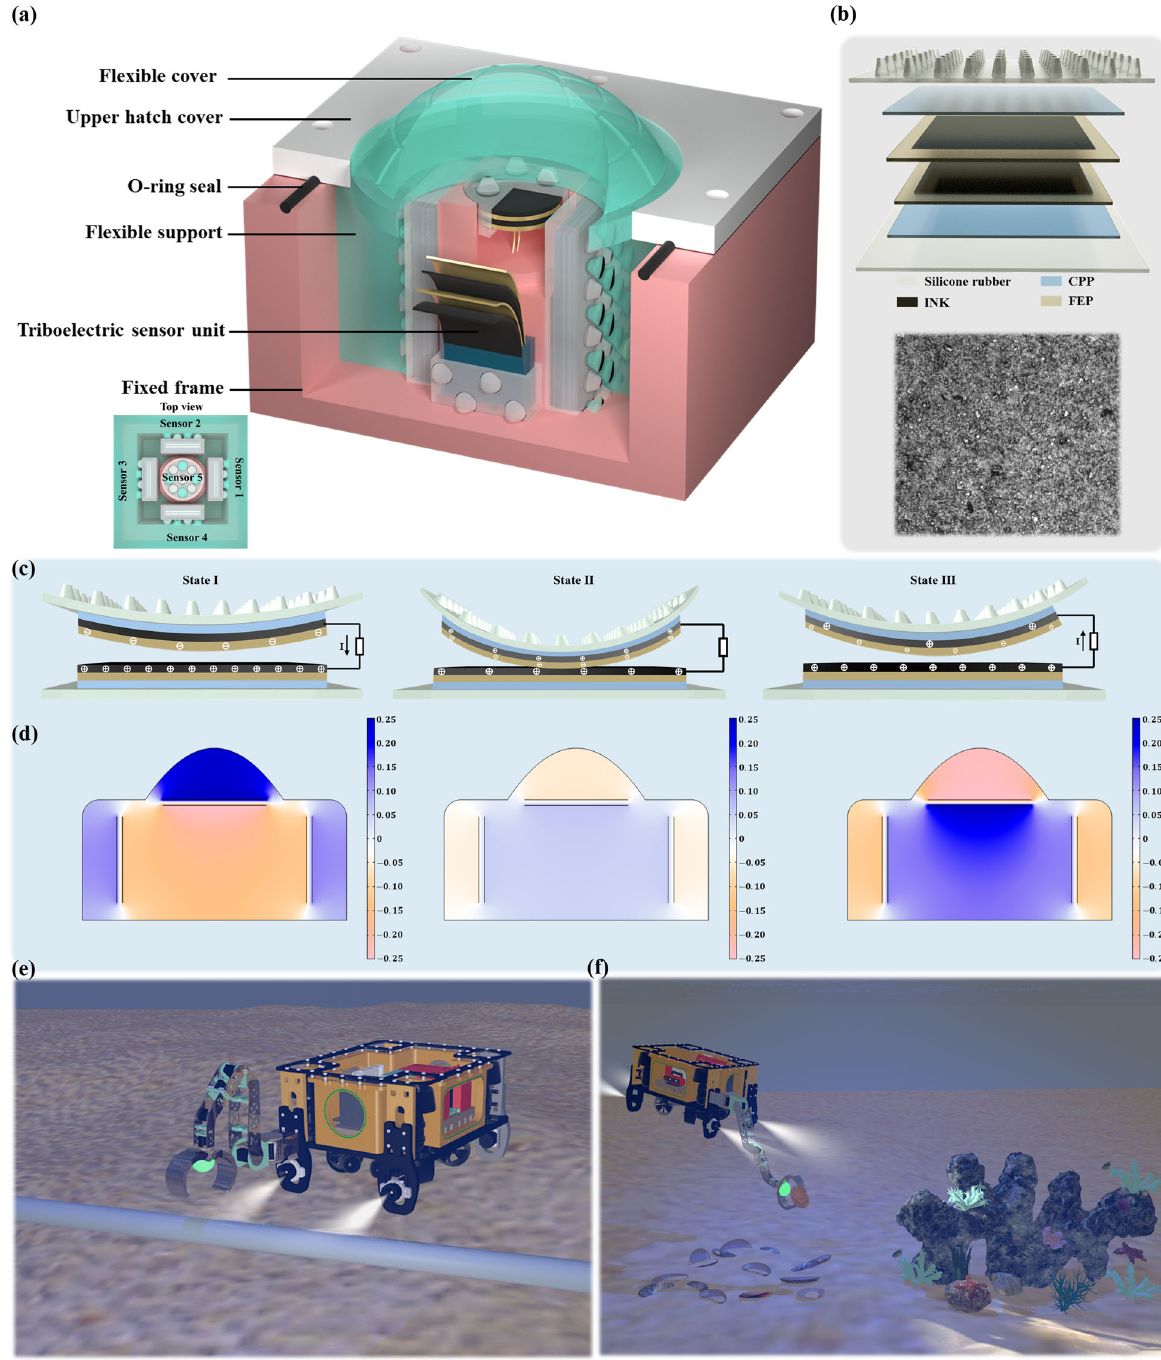
Fig. 1 The structure, working mechanism, and application of TPTS. a Structural diagram of TPTS. Inset: top view of the sensor unit layout. b Structural diagram of the sensing unit and SEM image of the FEP membrane surface. c Charge distribution during contact separation between FEP membrane and conductive ink. d Simulation of potential distribution using COMSOL software. (e) Application of the TPTS in pipeline non-destructive evaluation. f Application of the TPTS in underwater autonomous target separation motion between the conductive ink layer and the fl uorinated ethylene propylene (FEP) membrane for the tribo- electric sensing unit, producing charge transfer over the contact electri fi cation process. Experimental results demonstrate the potential for TPTS to be integrated into the manipulator mounted on underwater vehicles and used to complete numerous underwater tasks.